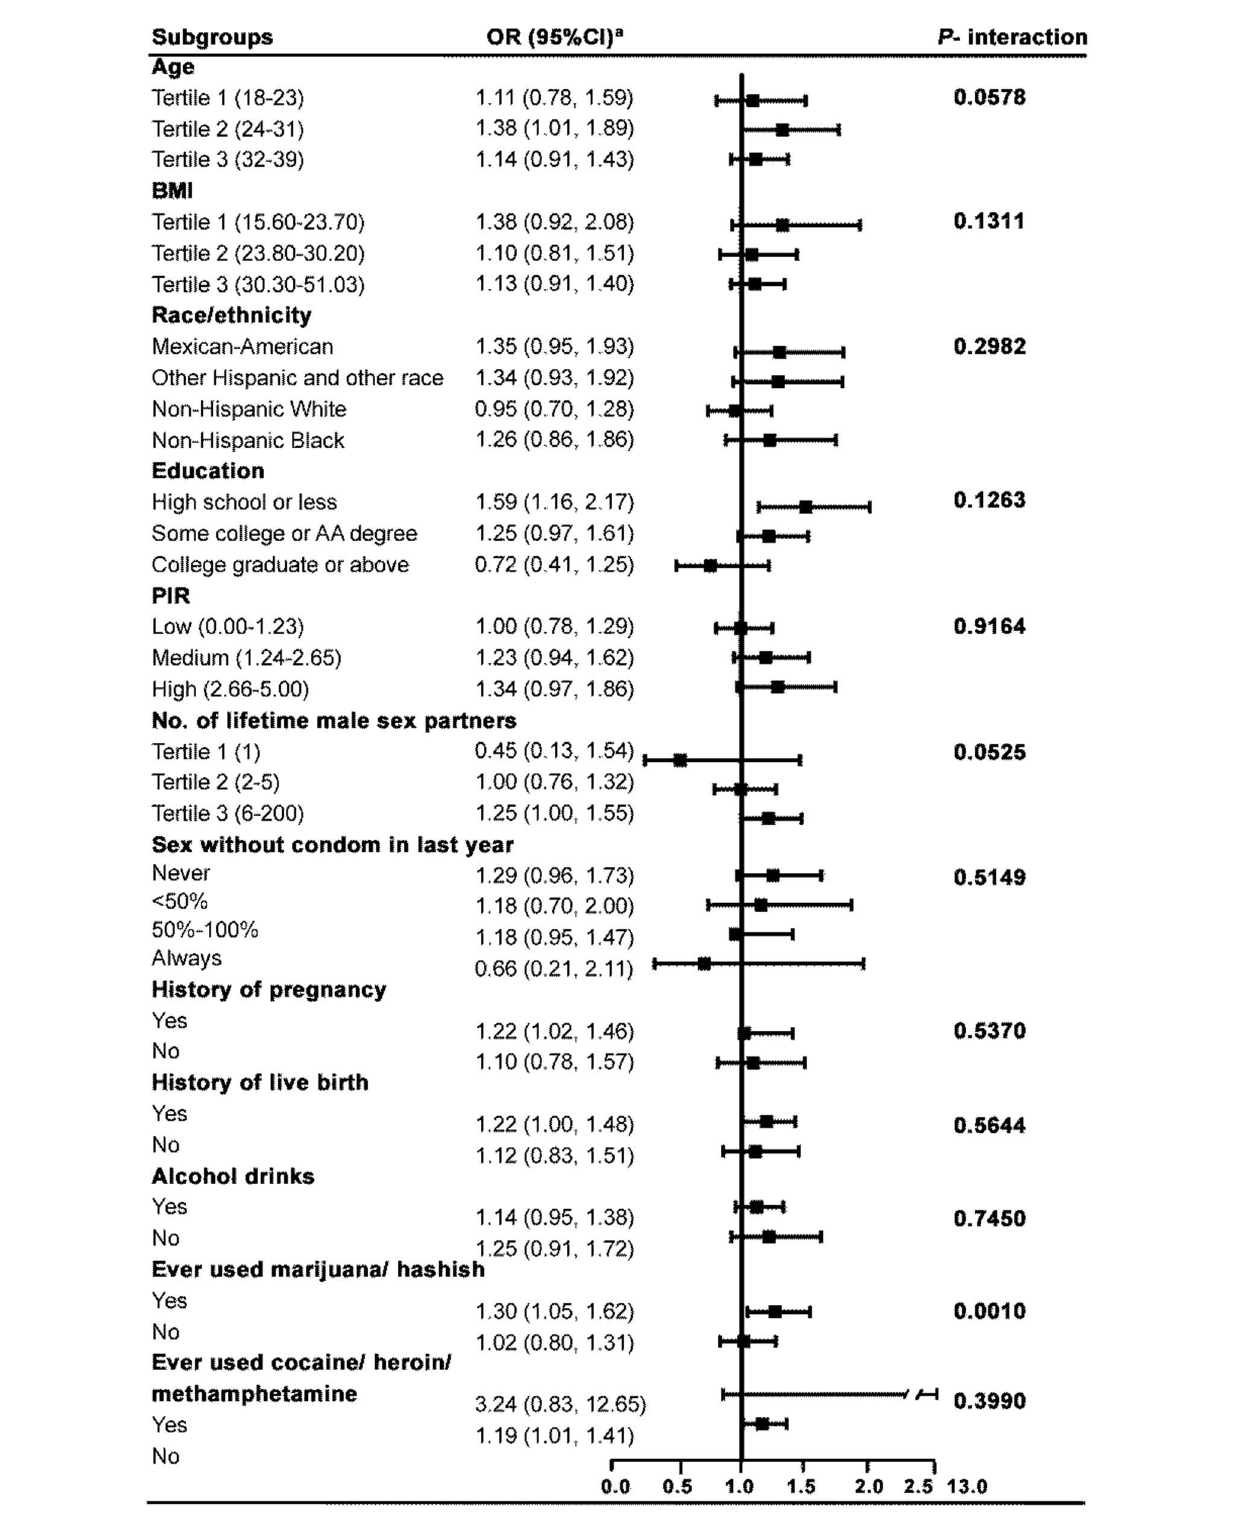
FIGURE3 Subgroup analysis for the association between Pgp3AbMBA and infertility. a Model adjusted for age, BMI, race, marital status, PIR, education level, alcohol consumption, male sex partners, ever pregnant, age at first sex, pelvic infection and recent chlamydia, except for the stratifying variable.